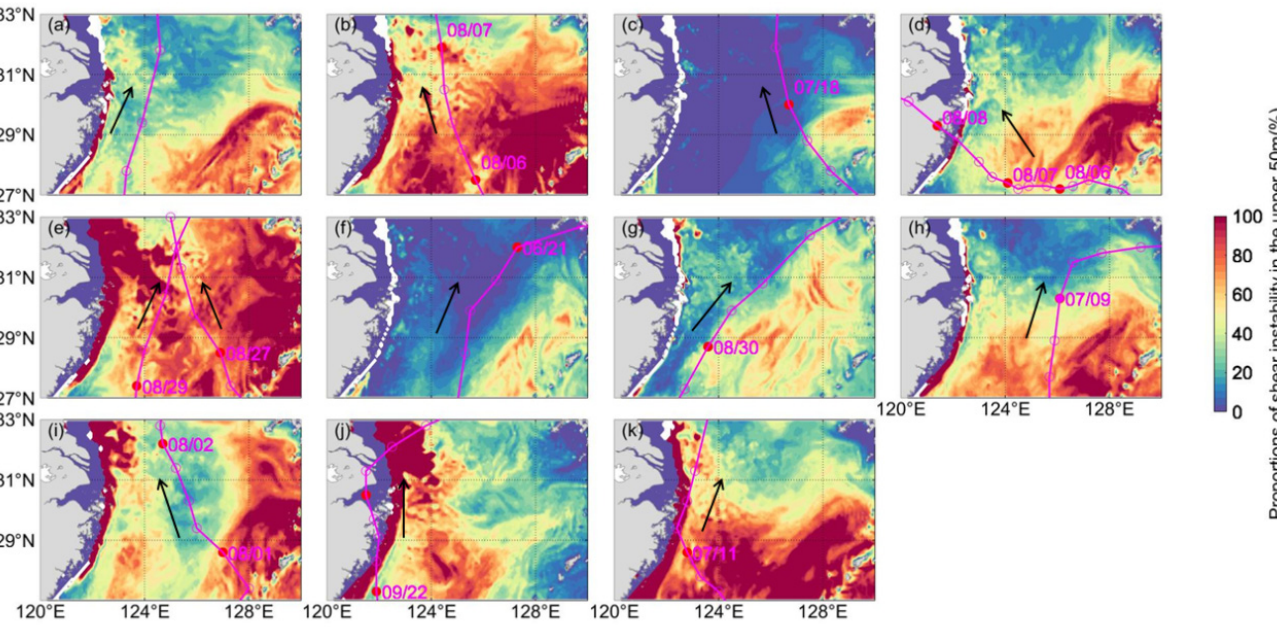
Figure 12. Proportions of shear instability in the upper 50 m induced by ( a ) Meari, ( b ) Muifa, ( c ) Khunan, ( d ) Haikui, ( e ) Tembin and Bolaven, ( f ) Leepi, ( g ) Kongrey, ( h ) Neoguri, ( i ) Nakri, ( j ) Fungwong and ( k ) Chanhom. Note that the proportion is averaged in the 1 day after the passage of the typhoon. The black arrow(s) in each subfigure denotes the moving direction of the typhoon(s).